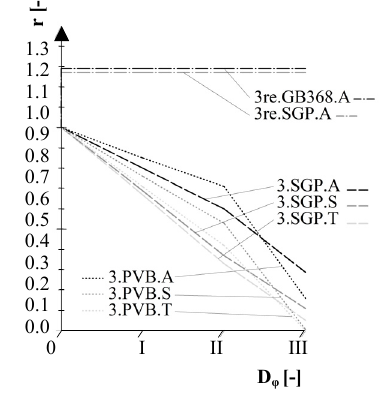
Figure 20: Relative redundancy curves for triple layer glass